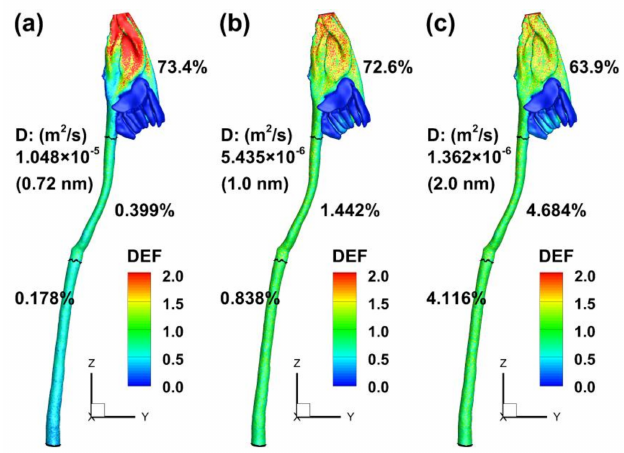
Figure 4. Effect of diffusivity on sub-regional deposition fractions: ( a ) D = 1.048 × 10 − 5 m 2 /s; ( b ) D = 5.435 × 10 − 6 m 2 /s; and ( c ) D = 1.362 × 10 − 6 m 2 /s.